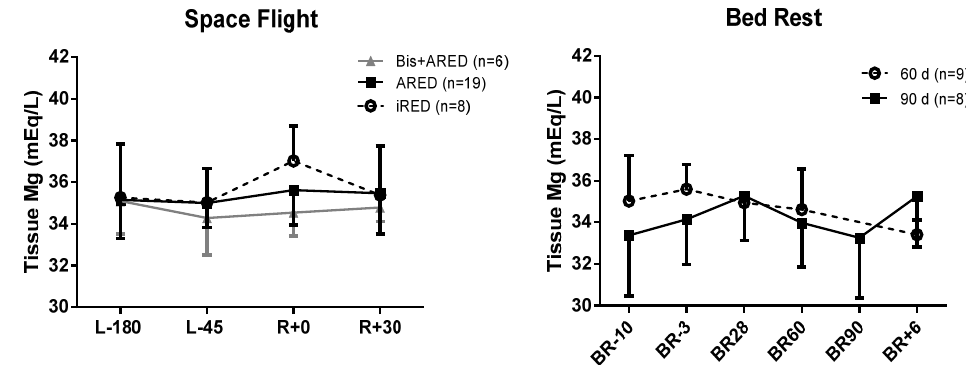
Figure 4. Sublingual tissue magnesium 180 and 45 days before flight (L ‐ 180 and L ‐ 45), on landing